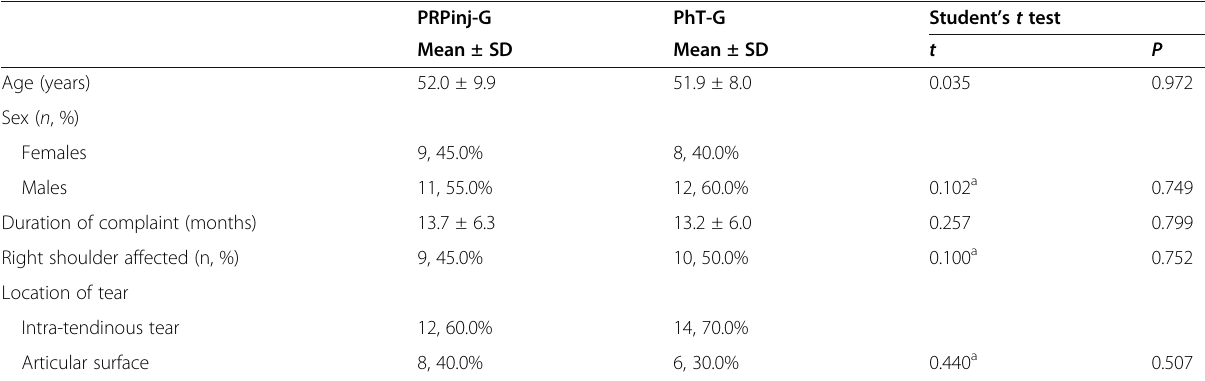
Table 1 Comparison of the age, sex, duration of complaint, side of affected shoulder, and site of tear between the PRPinj-G and PhT-G